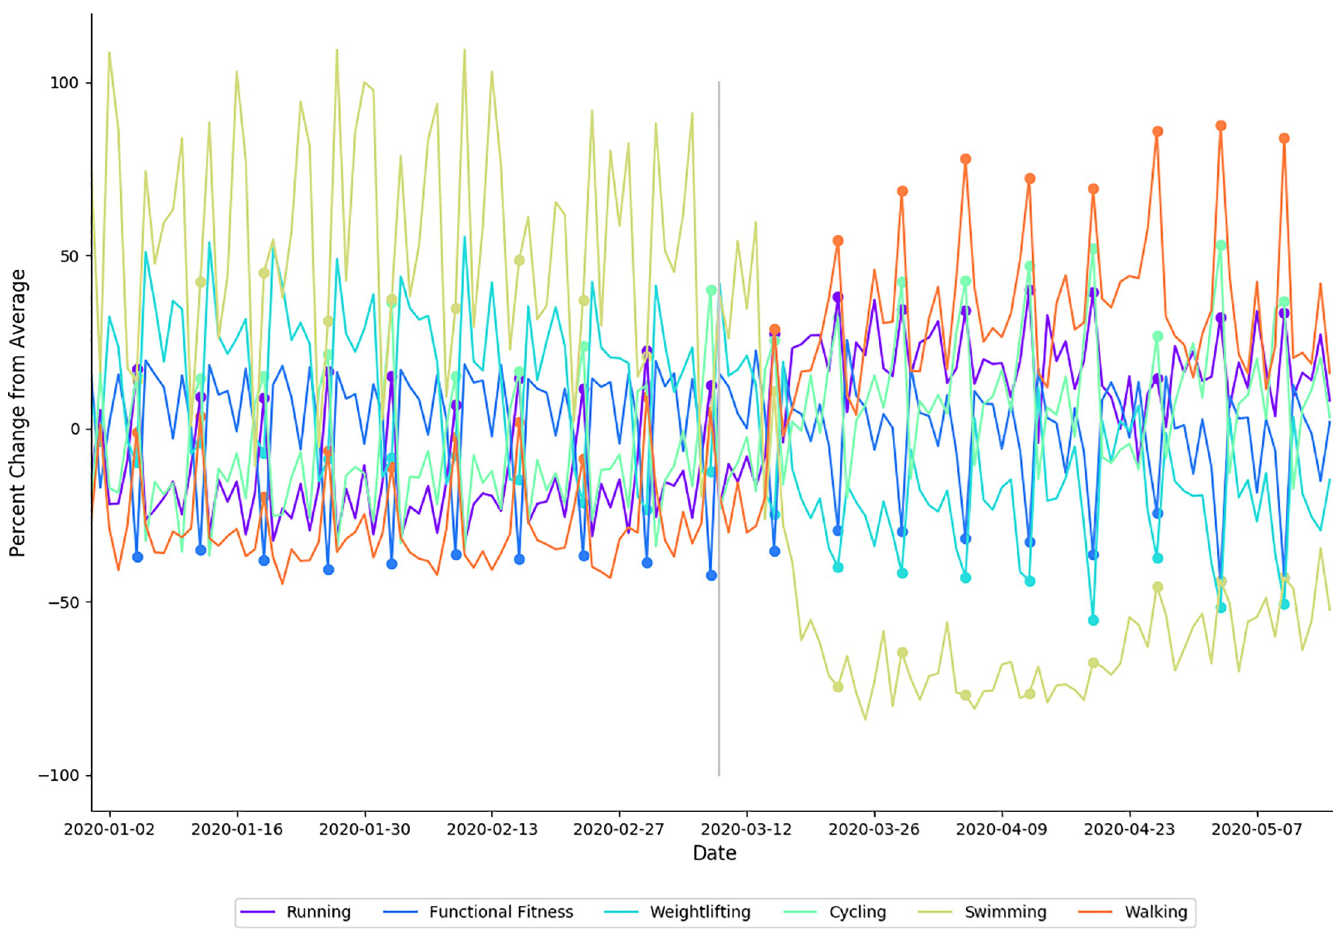
Fig 6. Percentage of change from average for the six most popular exercise modalities. Each modality is shown with a differently colored line as indicated in the legends. Filled circles indicate Sundays; a gray vertical line separates baseline from physical distancing.